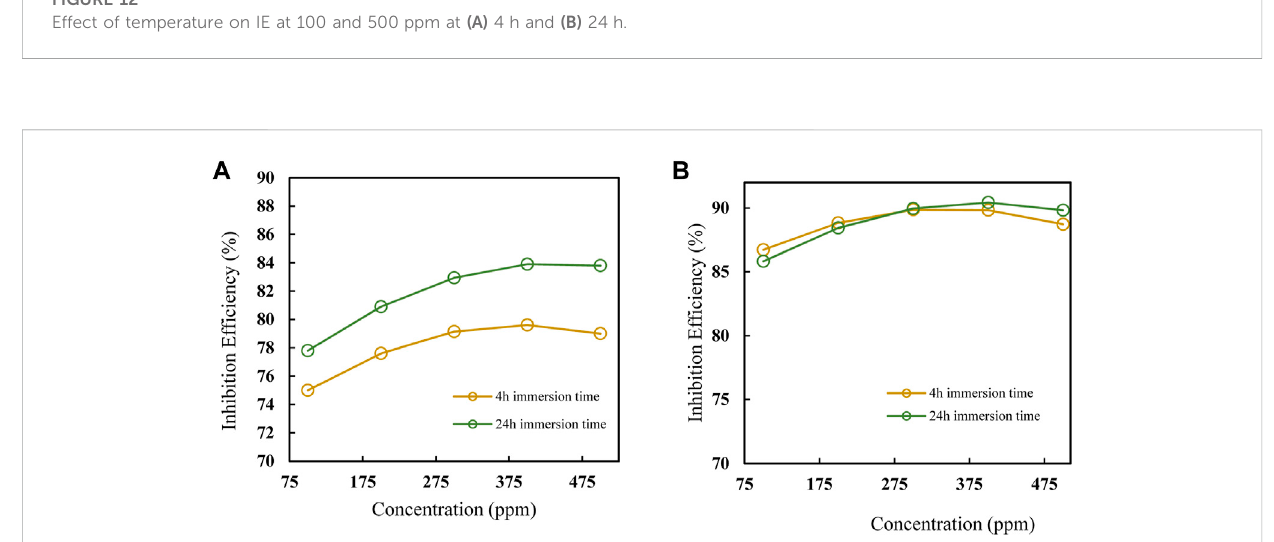
FIGURE 13 Effect of concentration on IE, at 4 h and 24 h for (A) 25 ° C and (B) 65 ° C.